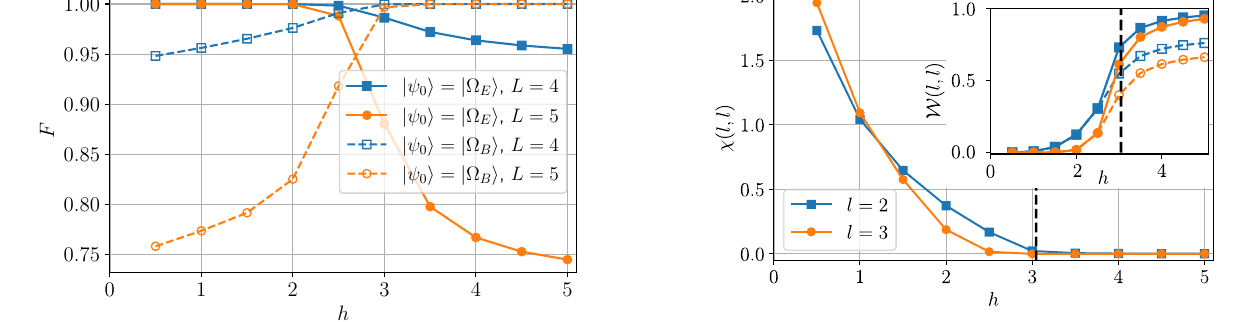
FIG. 8. Fidelity versus the magnetic coupling h . The data are obtained by using the two-step optimal schedules for L = 3 as an initial guess for ten local BFGS optimizations performed on the larger systems L = 4, 5 (we fixed P = 6). Here, we report the best result out of the ten runs. The filled and open symbols respectively correspond to | ψ 0 (cid:3) = | (cid:5) E (cid:3) and | ψ 0 (cid:3) = | (cid:5) B (cid:3) .